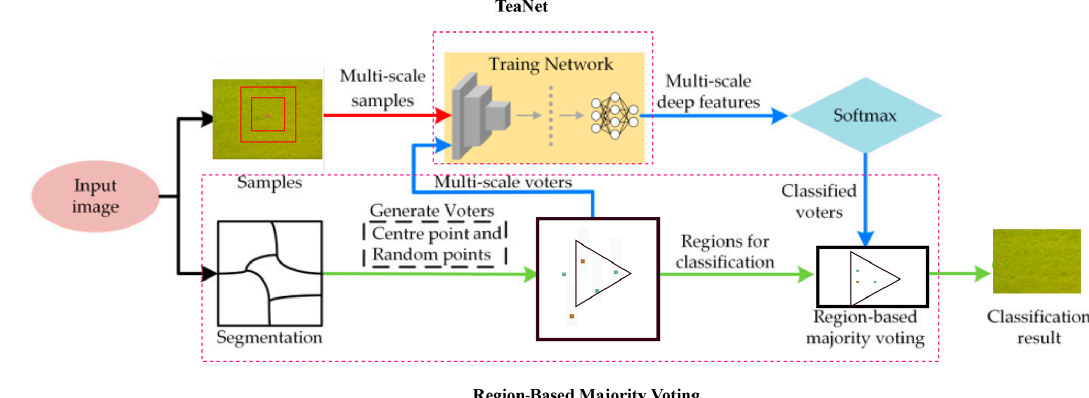
Figure 7. The workflow of the region-based majority voting for TeaNet.